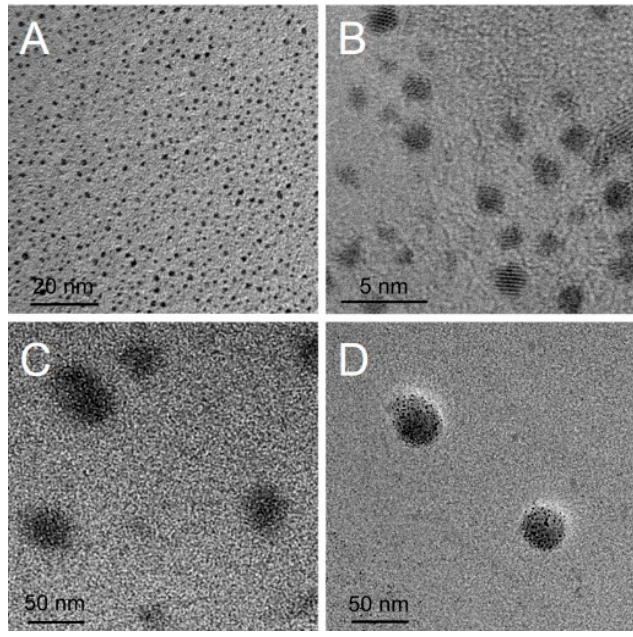
Figure 2. TEM images of ( A , B ) AuNC; ( C ) pNLS/DNA complexes at w/w ratio of 50:1; and ( D ) pNLS/DNA/AuNC complexes at w/w/w ratio of 50:1:5.